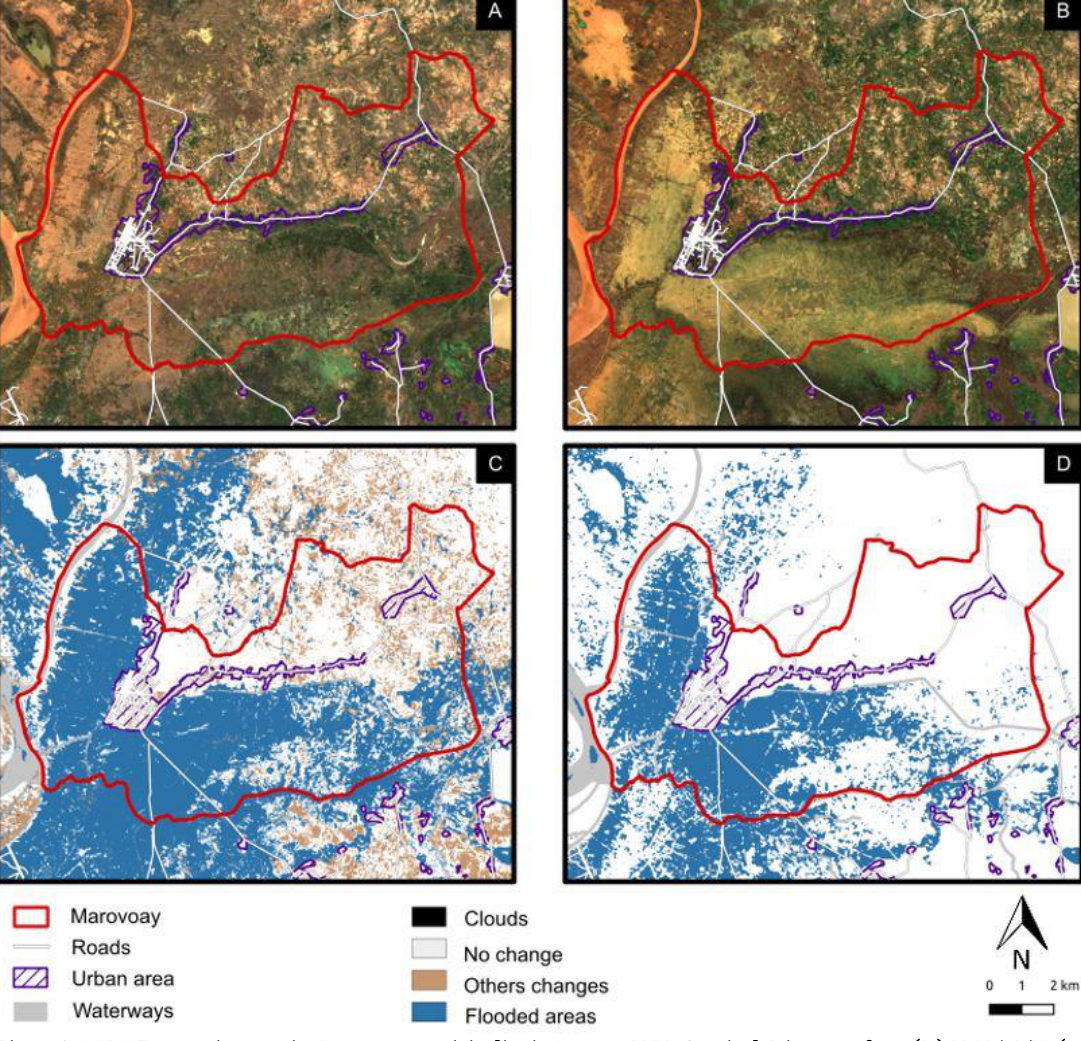
Figure 6. DIANE storm impacts in Marovoay municipality in January 2020. Sentinel-2 imagery from (A) 2019/12/05